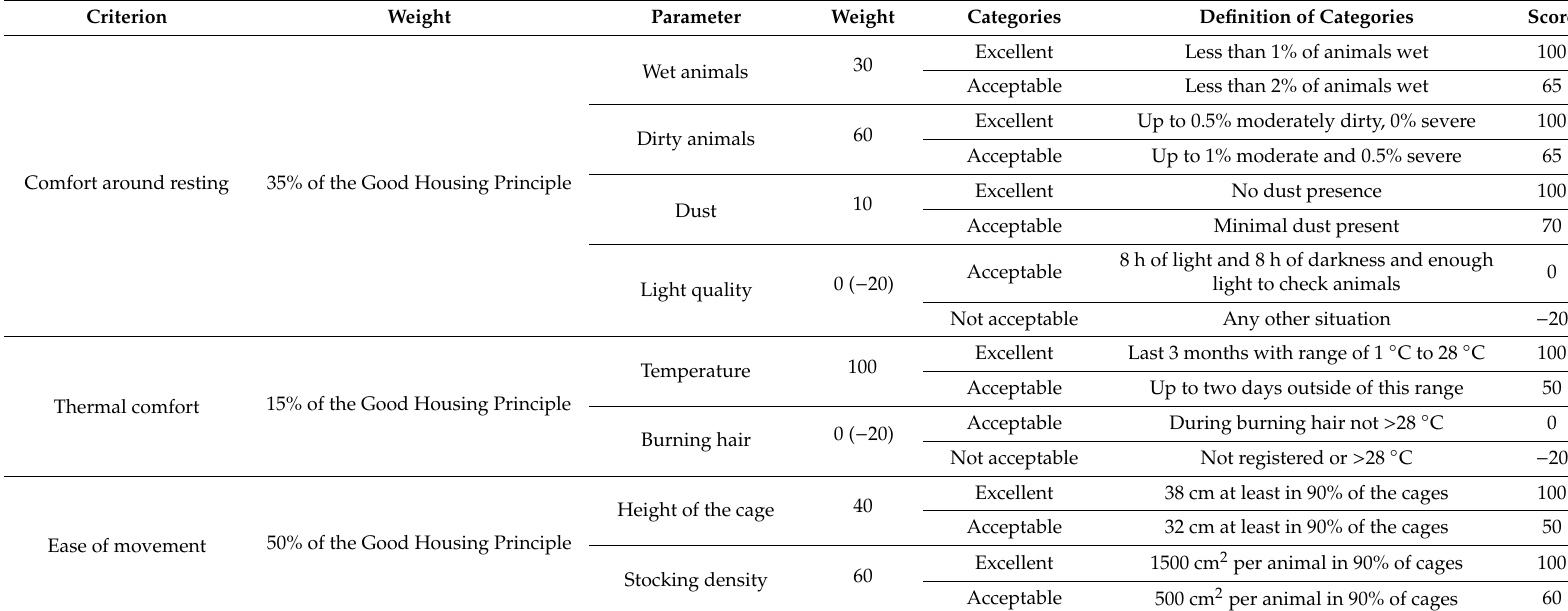
Table 3. Parameters used to assess the criteria of comfort around resting, thermal comfort and ease of movement within the Good Housing Principle. The weight means which percentage of the score of the total criterion is represented by each parameter. Some parameters, such as light quality, are only considered in the score when the acceptable value is not achieved, subtracting points from the overall score. Each parameter can be assessed according to two categories and are scored